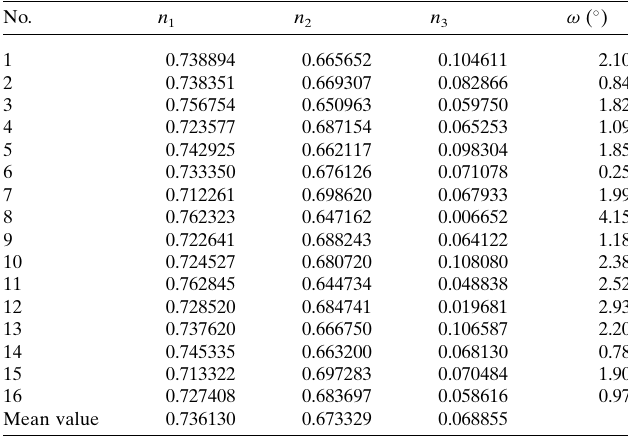
Table 1 Coordinates ( n 1 , n 2 and n 3 ) of the calculated austenite–martensite interface plane normals and the mean interface plane values; the deviation ( ! ) of each interface plane normal from the mean value was also calculated and is listed in the table.